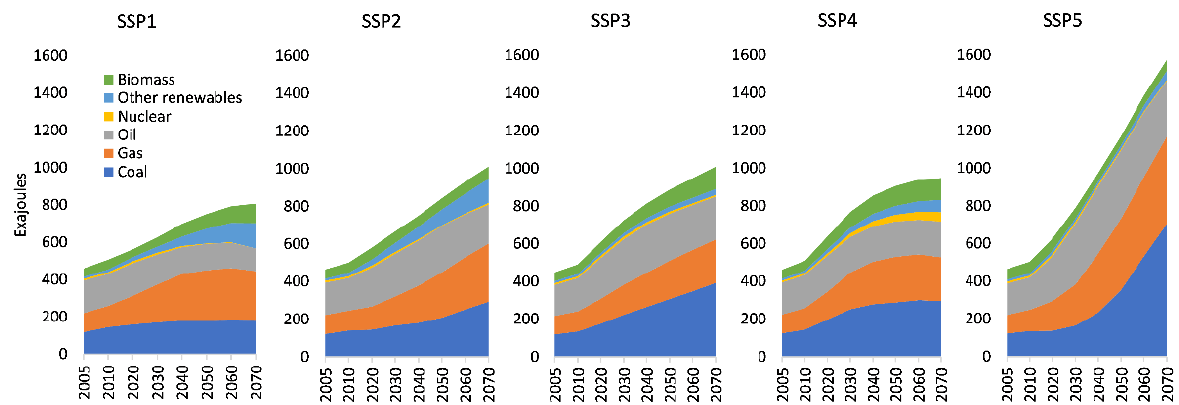
Figure 4. Global primary energy production for IPCC Shared Socioeconomic Pathways (source: [35]).